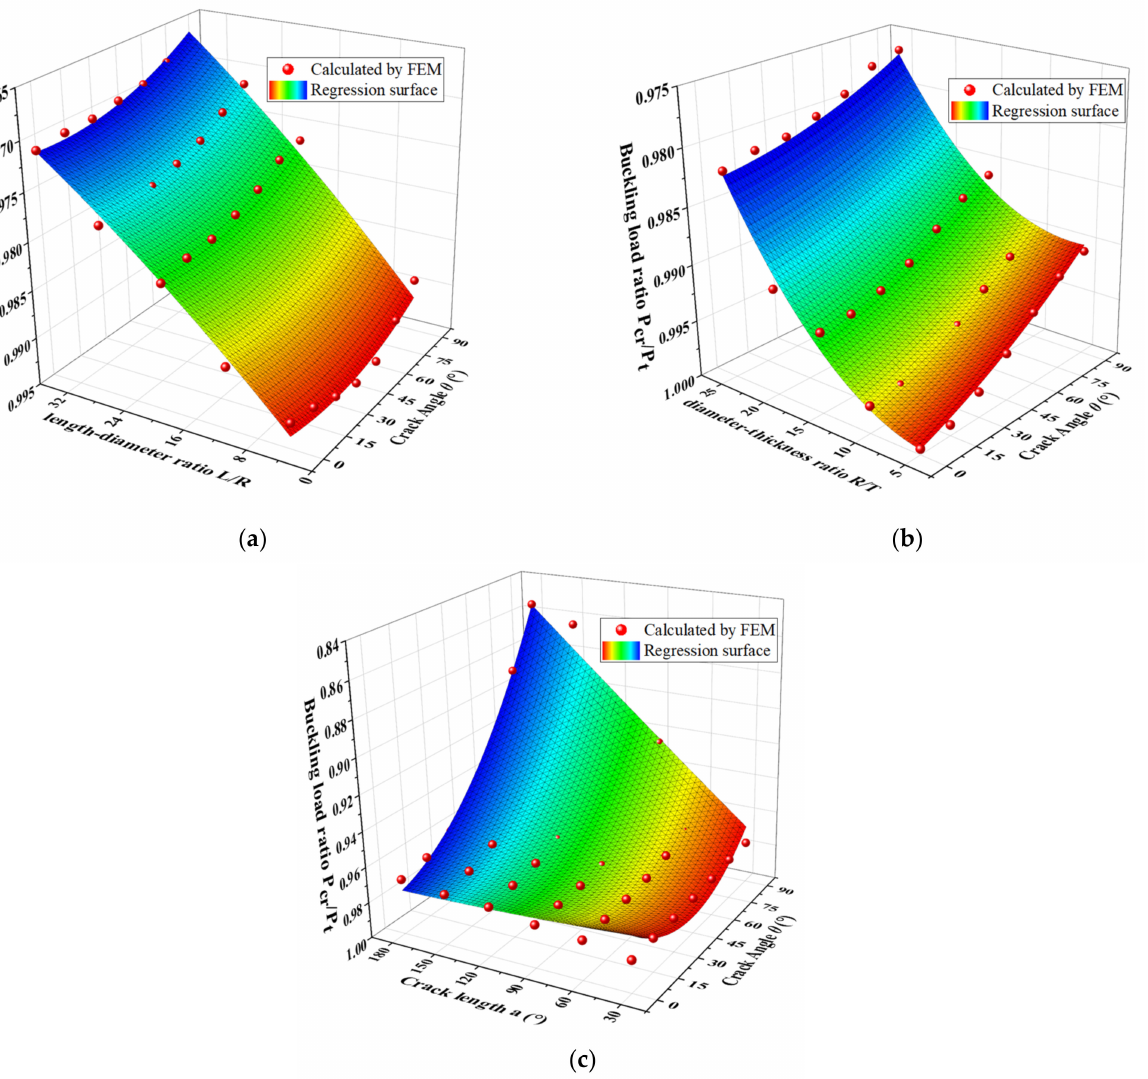
Figure 17. Relation of elastic buckling of cracked cylindrical shell with simple support ( a ) Different length-radius ratios and crack inclination angles; ( b ) Different radius-thickness ratios and crack inclination angles; ( c ) Different crack lengths and crack inclination